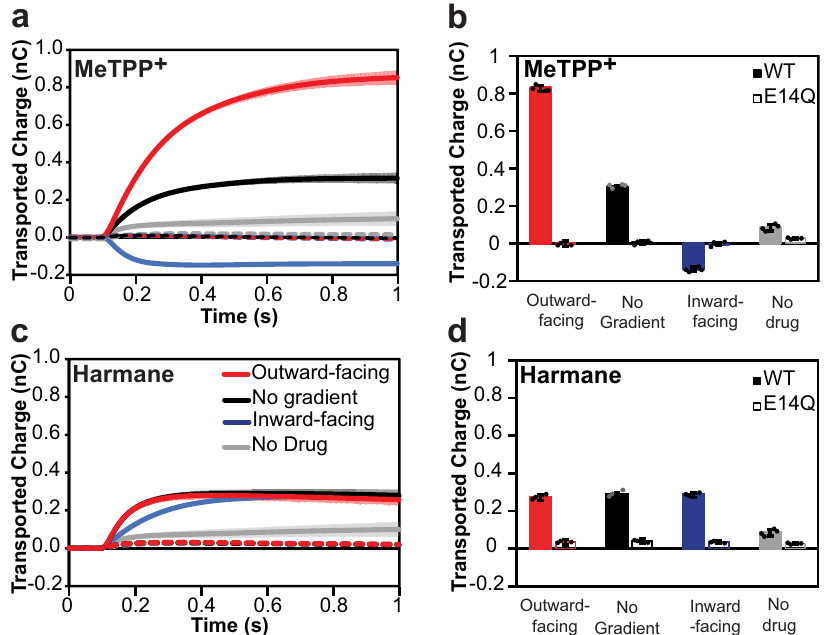
Fig. 5 | Harmane induces proton fl ux through EmrE. MeTPP + ( a , b ) behaves as expected for an antiported substrate (see Fig. 3). The total transported charge reverses when the drug gradient is inverted, characteristic of coupled antiport. In contrast, the harmane transportsignal( c , d )isthe same regardless of the harmane gradient, matching the expected behavior for downhill proton transport (proton leak). The current is minimal in the absence of drug ( b , c ; gray) or for liposomes